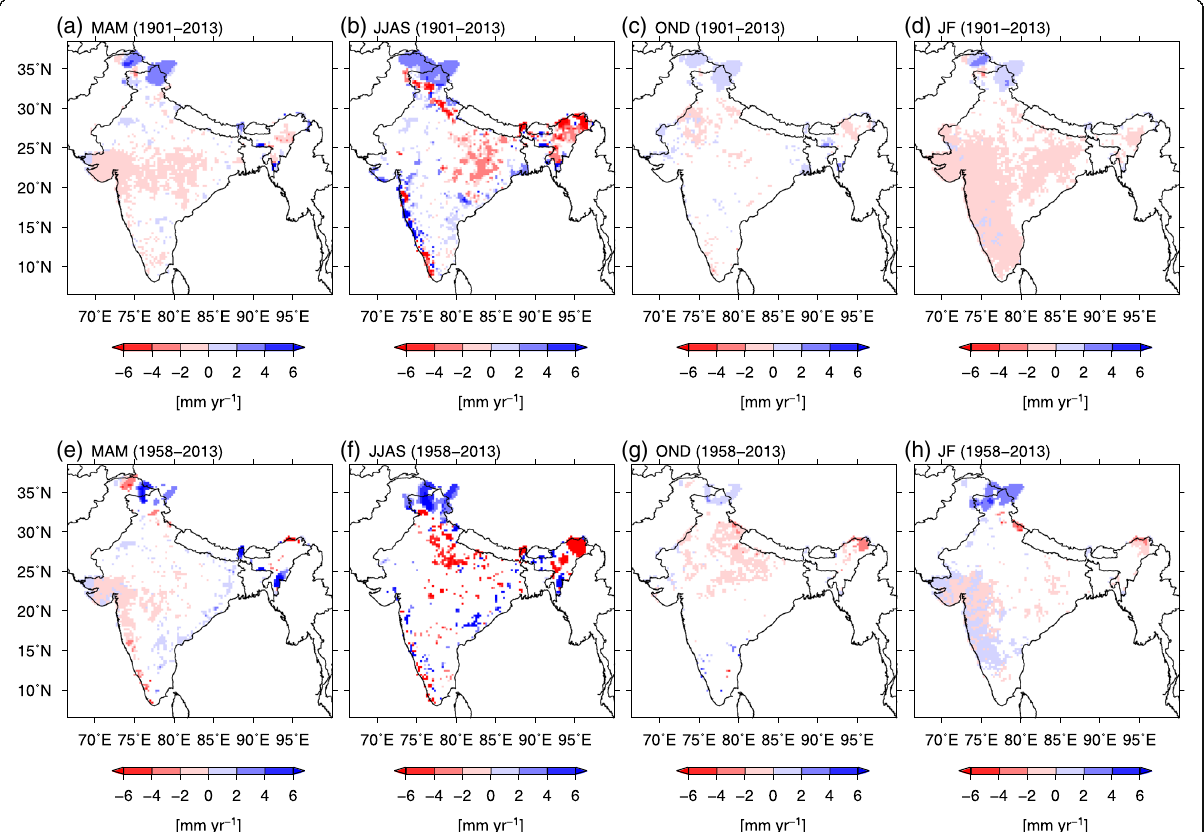
Fig. 1 Long-term trends of seasonal precipitation for 1901 – 2013 and 1958 – 2013. Slope of the linear trend of seasonal precipitation (mm year − 1 ) at the 5% significance level based on the Mann – Kendall test for the pre-monsoon season (MAM) ( a ), monsoon season (JJAS) ( b ), post-monsoon season (OND) ( c ), and winter season (JF) ( d ). Same as ( a ) but for 1958 – 2013 ( e ), same as ( b ) but for 1958 – 2013 ( f ), same as ( c ) but for 1958 – 2013 ( g ), and same as ( d ) but for 1958 – 2013 ( h